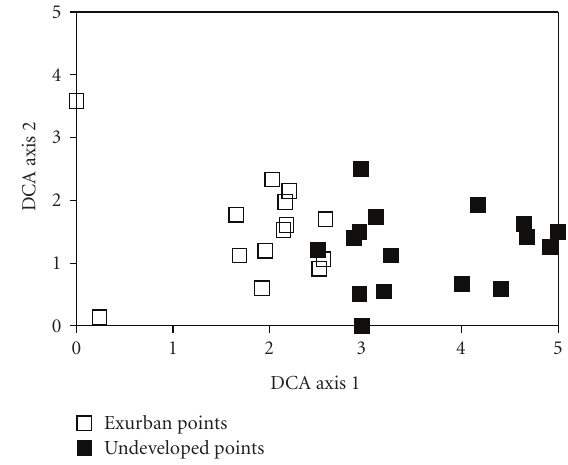
Figure 5: Detrended correspondence analysis of bird communities. Each point represents the position in ordination space of the bird community detected at one sampling point. The two axes show the relative position of each point in the multidimensional space defined by the species found at each point. Thus, points with similar bird communities cluster together on the graph. The first axis is the one along which most of the variation in the ordination space is arranged (eigenvalue = 0.67) the second axis is the second most important axis through the ordination space (eigenvalue =